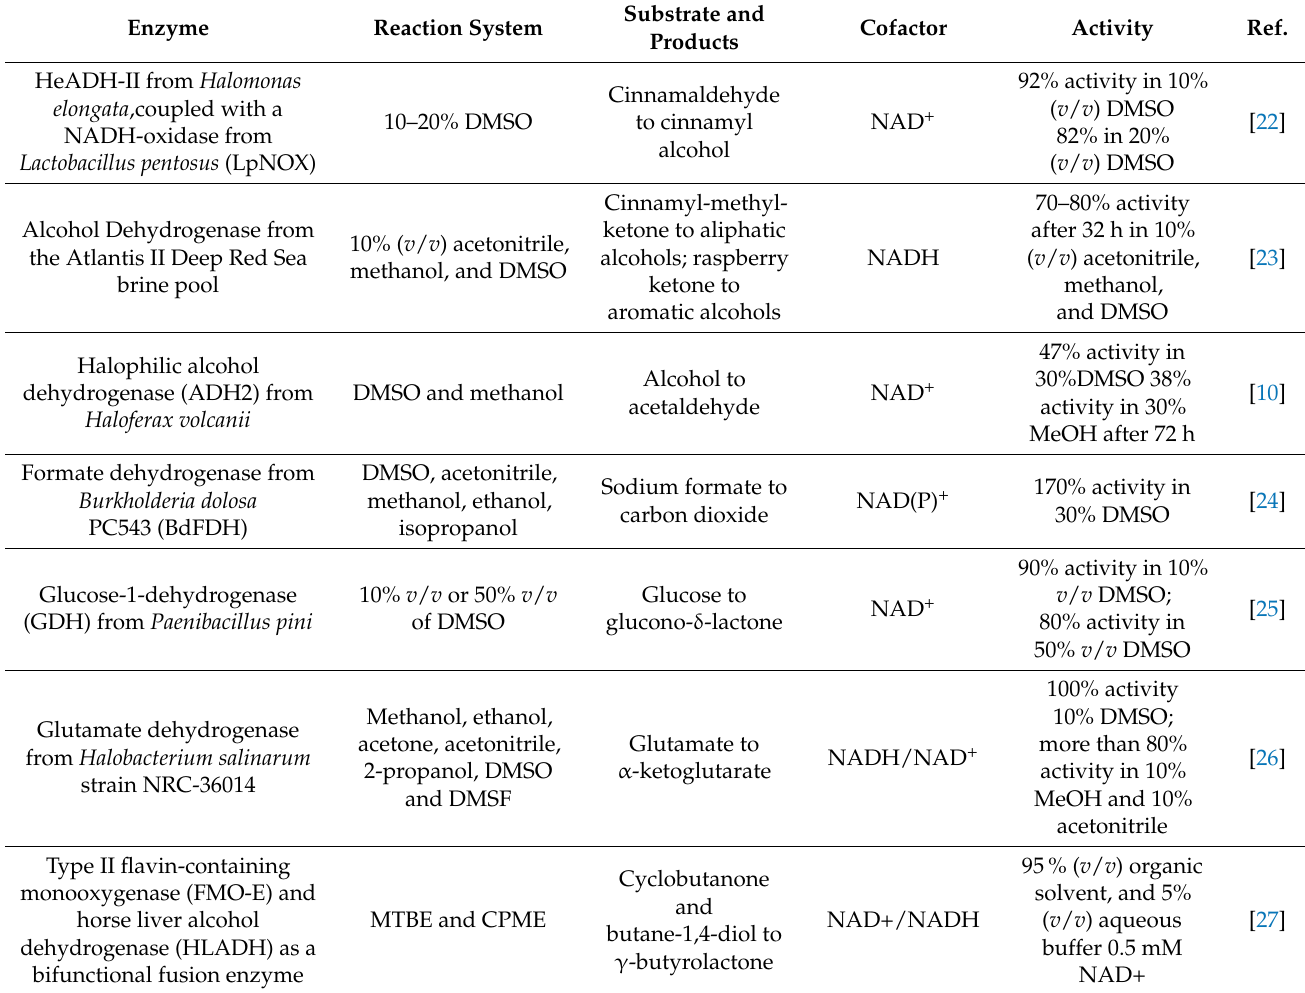
Table 1. Dehydrogenase in the reaction system with organic